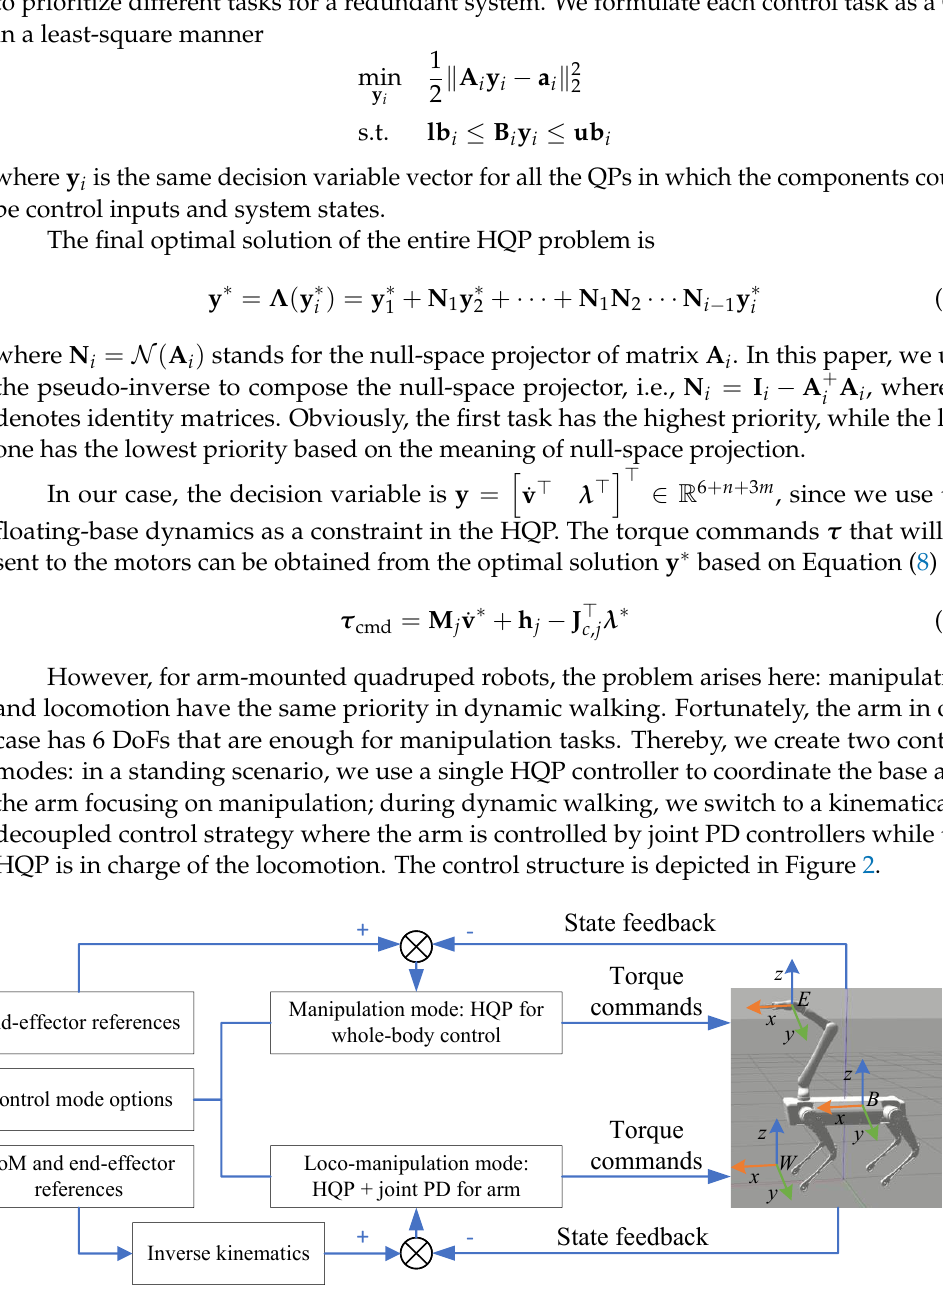
Figure 2. The system diagram. The joystick sends velocity commands to tele-operate the end- effector and the torso. Trajectory planners plan the task space reference trajectories sent to the proposed controllers. The proposed controllers implement trajectory tracking while satisfying physical feasibility